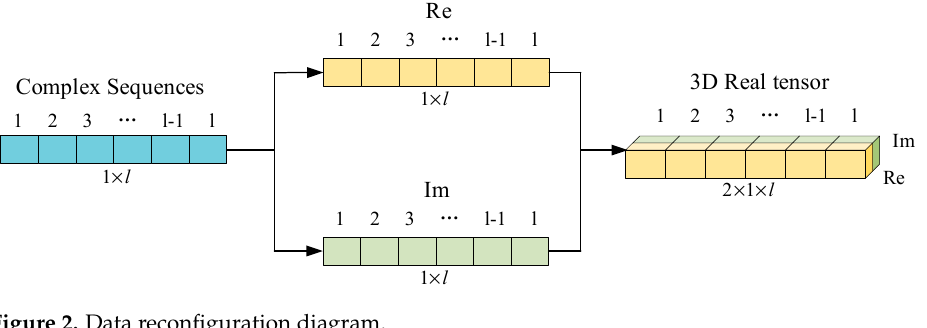
Figure 2. Data reconfiguration